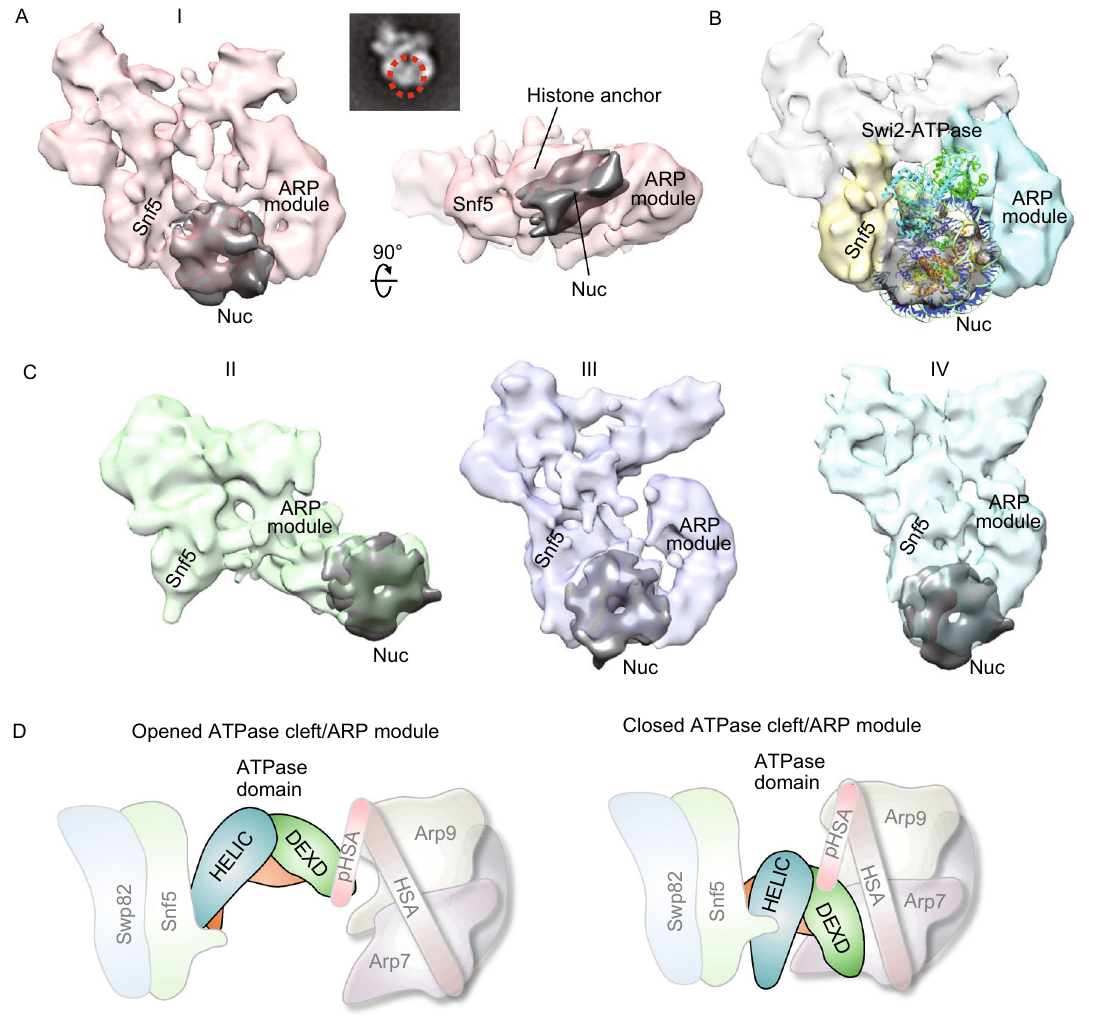
Figure 2. 3D reconstructions of SWI/SNF-nucleosome assembly in different states . (A) 2D and 3D structure of typical SWI/ SNF-nucleosome assembly (state I). The dark gray density corresponds to a nucleosome. (B) Details of the SWI/SNF-nucleosome interfaces. The recently published cryo-EM reconstruction of the Snf2-nucleosome assembly (PDBID: 5X0Y) (Liu et al., 2017) is fi tted as a rigid body into the SWI/SNF-nucleosome structure. (C) EM reconstructions of the other three intermediate states of SWI/SNF stably binding to a nucleosome (state II, III and IV). (D) Schematic diagram of the structural rearrangements of the Arp module during nucleosome binding. The mobility of the Arp module may modulate the conformation of the ATPase domain as a conformational switch on the SWI/SNF remodeling